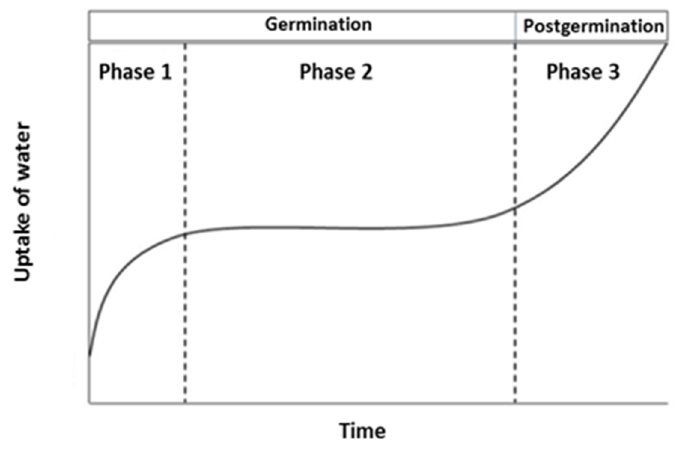
Figure 6. Germination and post-germinative growth divided into three phases regarding water uptake (adapted after Bewley [8]).